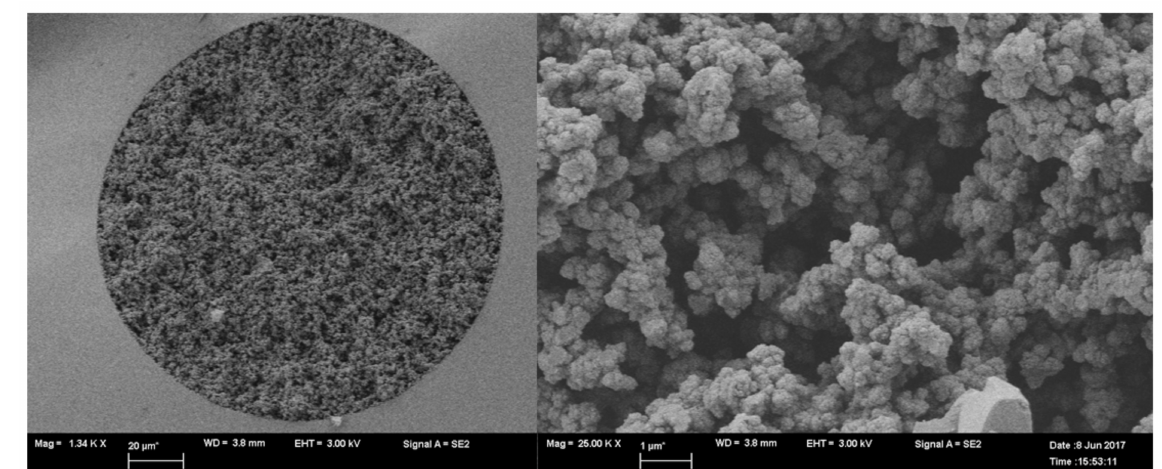
Figure 4. SEM of column D3 at 1200 × and 25,000 × (left and right, respectively) showing small microglobules with rough surface.